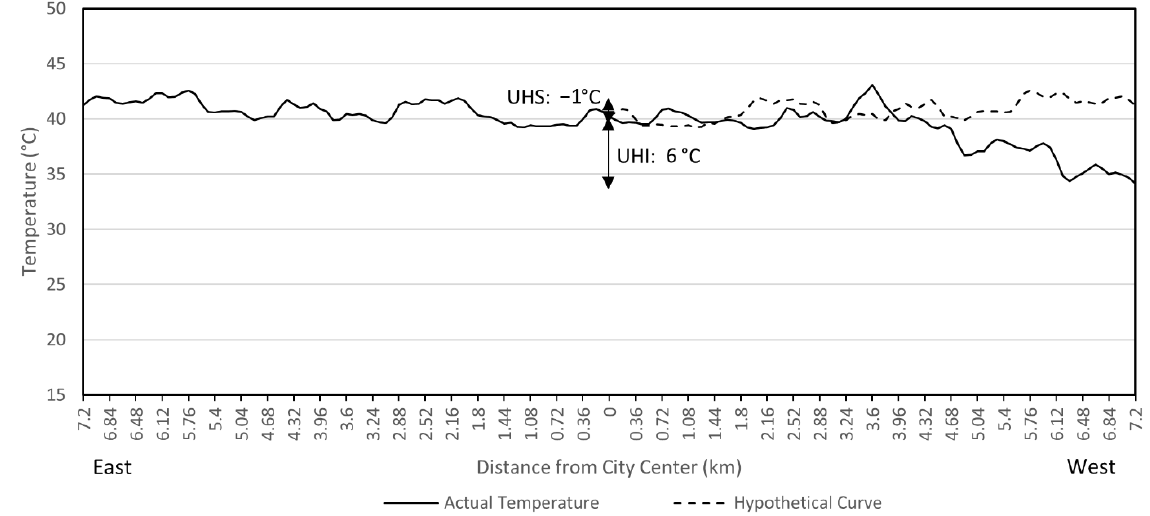
Figure 5. Surface temperature cross section along an east-west transect parallel to the coastline and across the city of Tangier.